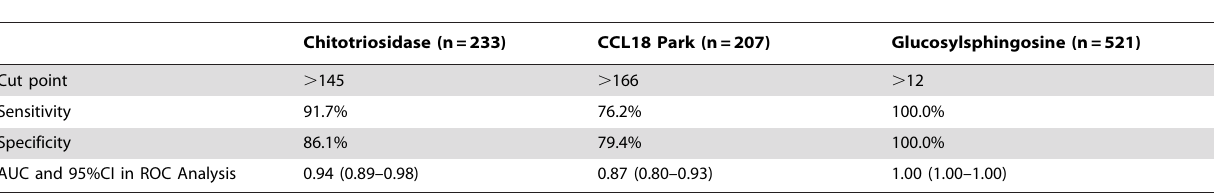
Table 2. Sensitivity and specificity for different biomarkers with regard to diagnosis of GD.